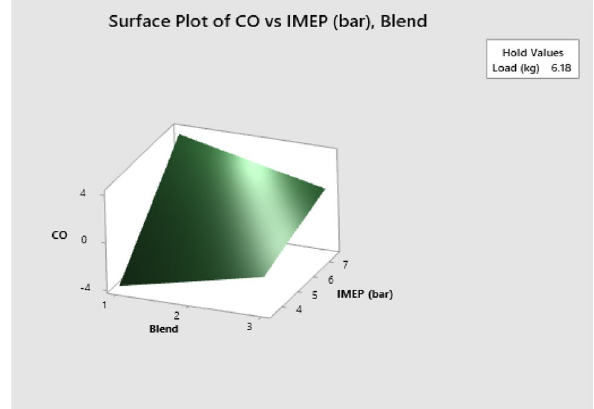
Fig. 27 Surface plot of CO with nanoparticles